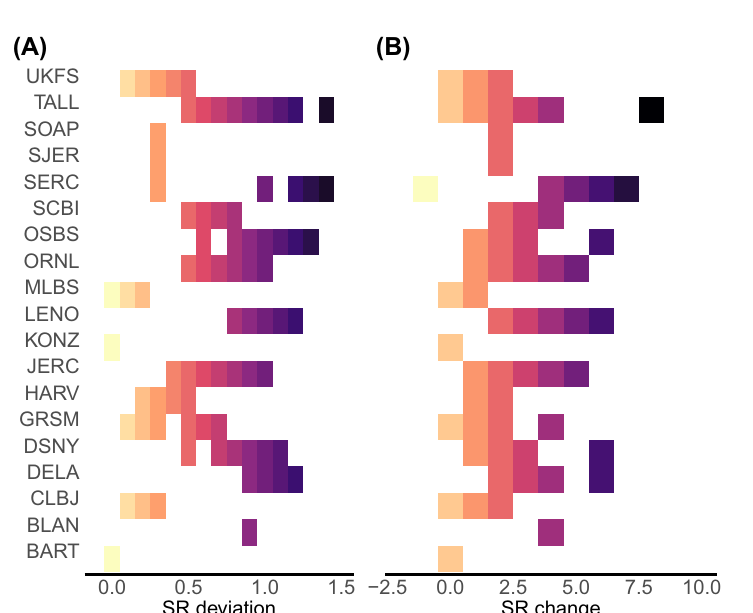
Figure 4. Accuracy of the number of co-occurring oak species predictions at site and plot scale. ( A ) Species richness deviation, measured as the absolute deviation in assemblage richness predictions divided by the maximum observed NEON plot species richness, where low and high values represent high and low accuracy respectively. ( B ) Species richness change, that represent the species loss or gain at plot scale. Negative values represent the number of species lost (underprediction) while positive values the gain of species